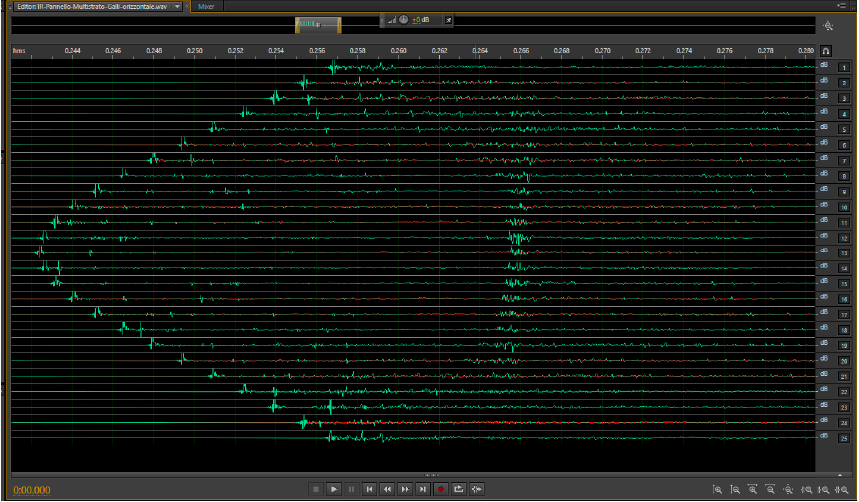
Figure 4. Example of a polar plot of RIR data measured inside Room A: direct sound on the left and reflected sound in the center.